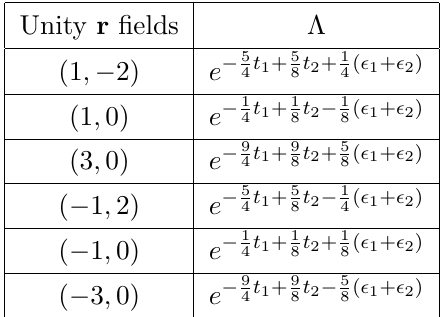
Table 2 . The non-equivalent unity r (cid:12)elds and (cid:3) of local F